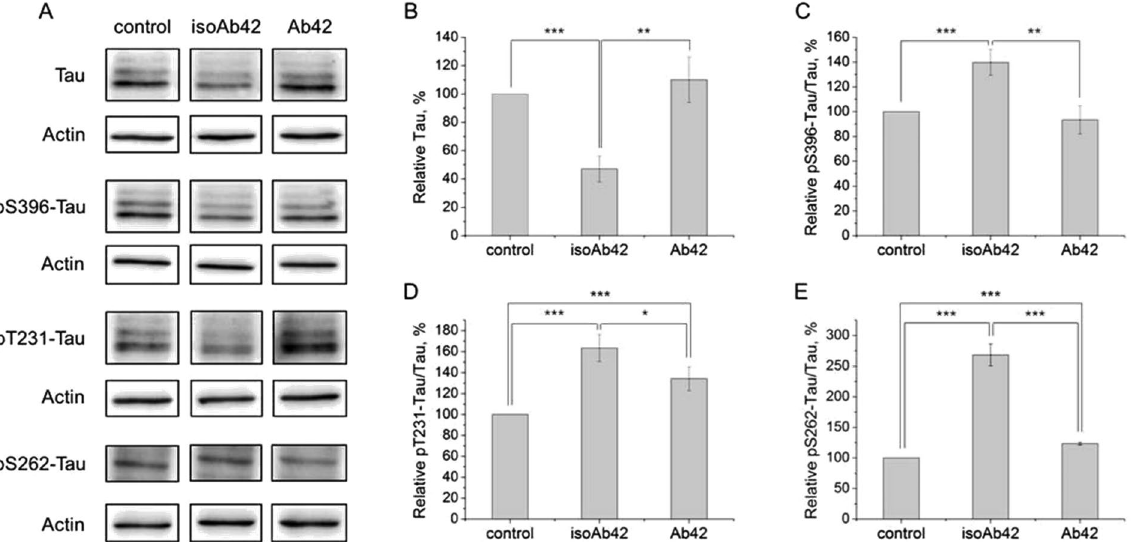
Figure 8. Effect of A β 42 and isoA β 42 treatment (10 μ M, 24 h) on the total tau level and the phosphorylated tau level in SH-SY5Y cells. After incubation with A β 42 or isoA β 42, the cells were lysed, and the proteins were separated by SDS-PAGE and detected by Western blot using antibodies against total tau, phosphorylated S396 tau, phosphorylated T231 tau or phosphorylated S262 tau ( A ). The bars represent the changes in the total tau level ( B ), phosphorylated S396 tau ( C ), phosphorylated T231 tau ( D ) or phosphorylated S262 tau ( E ), expressed as a percentage of the total tau level in the control group, which was not treated with A β . Changes to tau phosphorylation levels were normalized to its total amount. Each value is the mean ± SD of at least three independent experiments; * p < 0.02, ** p < 0.005, *** p <